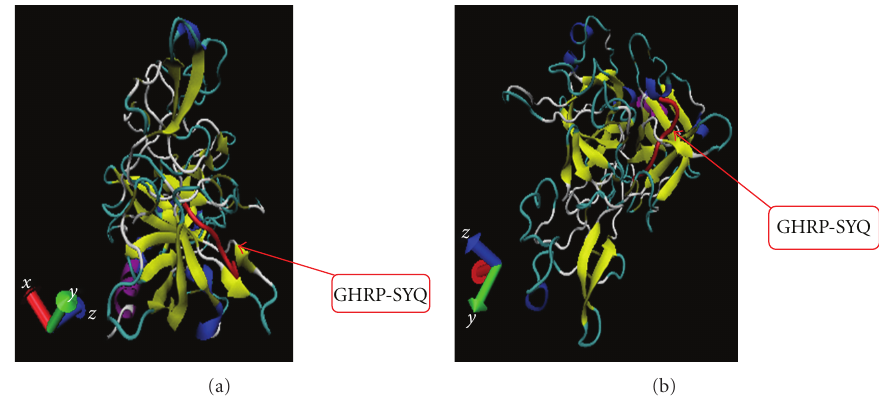
Figure 2: Cartoon Ribbon display in VMD 1.8.7 program for two di ff erent views of GHRP-SYQ-K2S modeled with MODELLER 9V1. (a) Left back view for a ribbon model of GHRP-SYQ-K2S modeled with MODELLER 9V1 automodel package (chimeric part shown in orange). (b) Left bottom view for a ribbon model of GHRP-SYQ-K2S modeled with MODELLER 9V1 automodel package; purple: alpha helix, blue: 3 10 helix, yellow: extended beta, tan: bridge beta, cyan: turn, and white: coil.